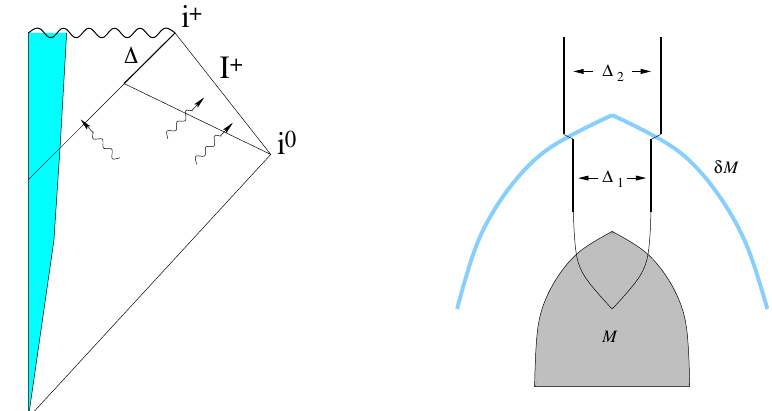
Figure 1 . Examples of NEHs in the asymptotically flat (i.e. Λ = 0 ) case. Left panel: non-spherical gravitational collapse. Since the radiation falling into the black hole rapidly decreases at late time, the portion ∆ of the event horizon is well modeled by a perturbed NEH. Right panel: spherical collapse of a star followed by the collapse of a spherical shell some time later. ∆ 1 and ∆ 2 are both NEHs. The event horizon lies outside ∆ 1 and grows to join on to ∆ 2 , although there is no matter or gravitational radiation falling cross